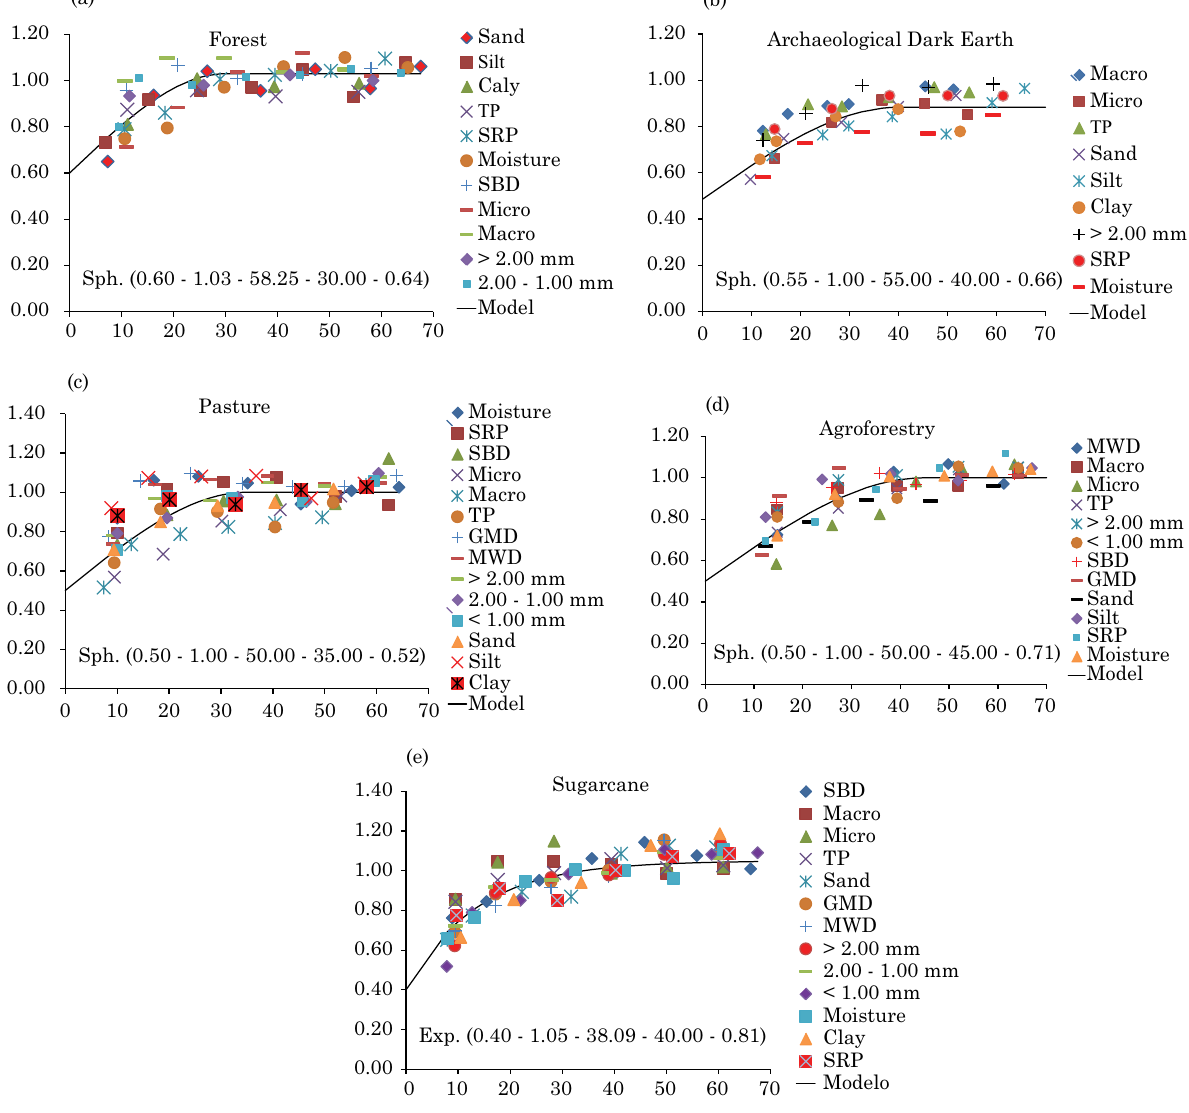
USE OF SCALED SEMIVARIOGRAMS IN THE PLANNING SAMPLE OF SOIL PHYSICAL PROPERTIES...